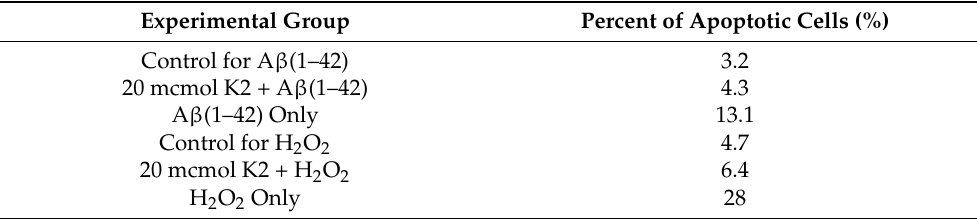
Table 1. The effects of vitamin K2 on A β (1–42) and H 2 O 2 induced apoptosis, as described by [42]. Experimental